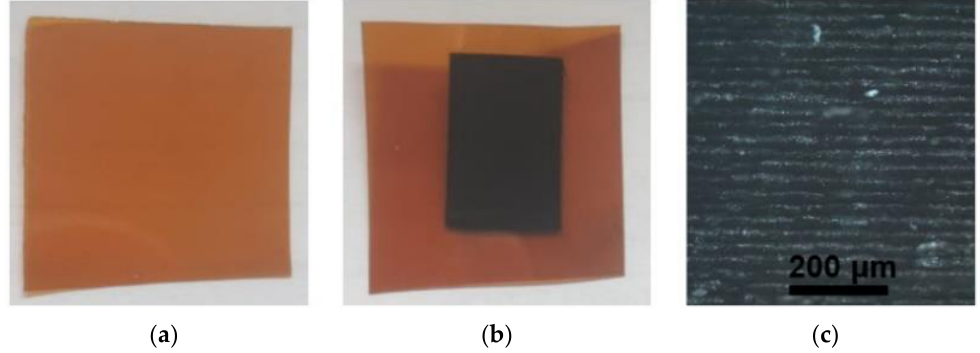
Figure 4. Polymer Kapton PI film: ( a ) before laser treatment, ( b ) after laser treatment and ( c ) magnified (×10) view of the laser-treated area.